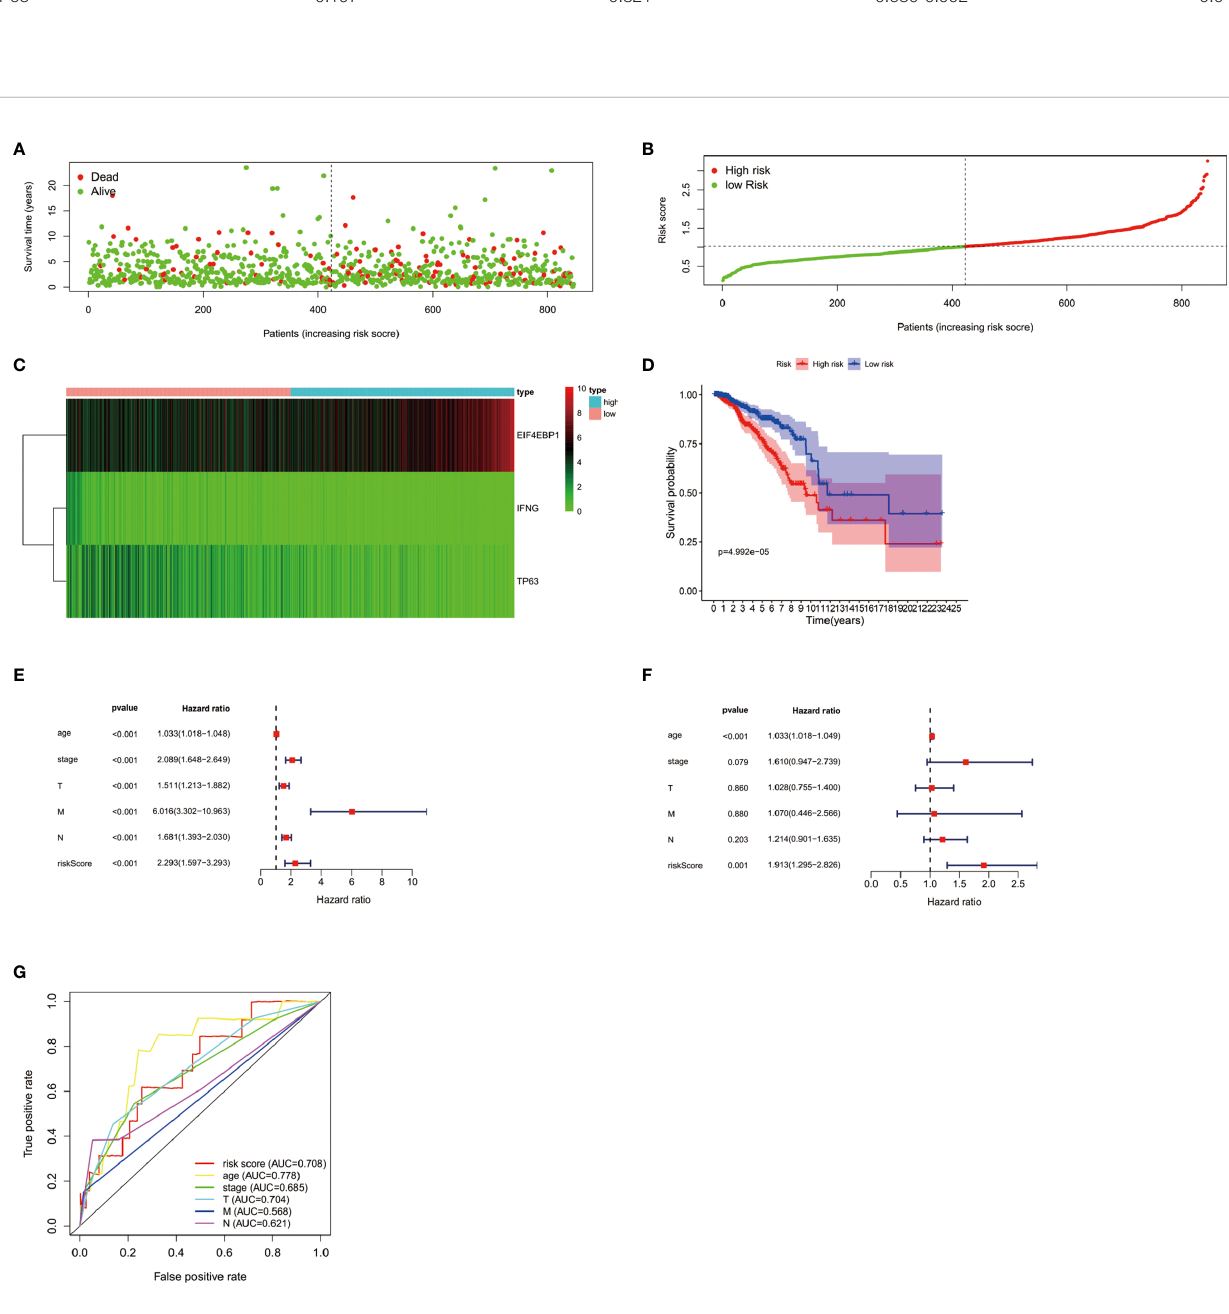
FIGURE 2 | (A) The distribution of prognostic indicators in different groups of breast cancer patients. (B) The distribution of risk score in different groups of breast cancer patients. (C) Heatmap of the expression pro fi le of DEARGs. (D) Survival curves of breast cancer patients in the high and low risk groups. The forest plots showed univariate Cox regression analysis (E) and multivariate Cox regression analysis (F) in breast cancer. (G) The survival-dependent receiver operating characteristic (ROC) curve con fi rmed the prognostic signi fi cance of risk score based on ARGs.